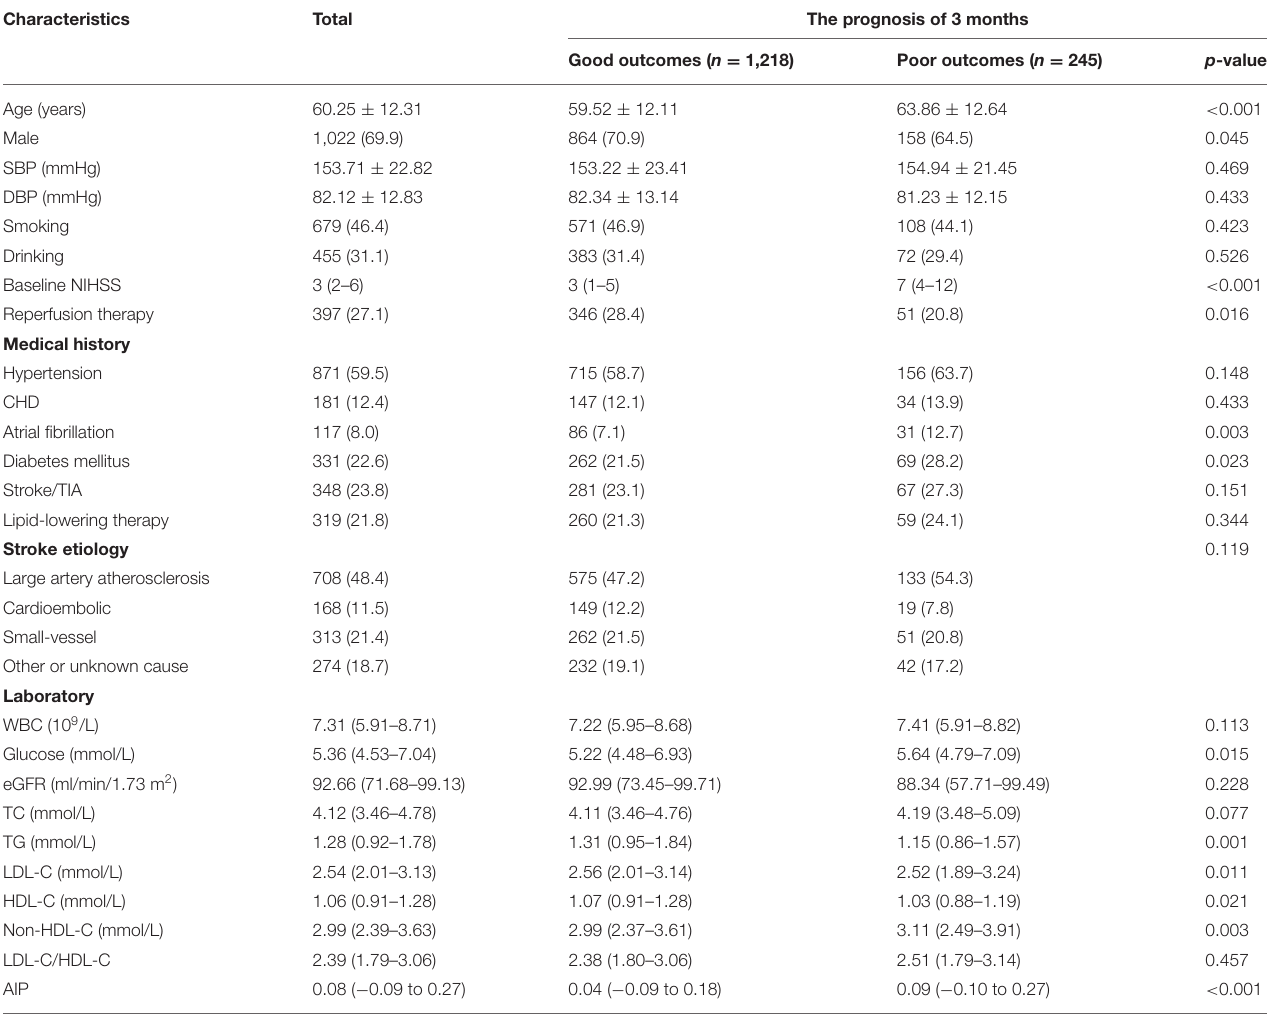
TABLE 1 | Characteristics of patients included according to 3-month outcomes.